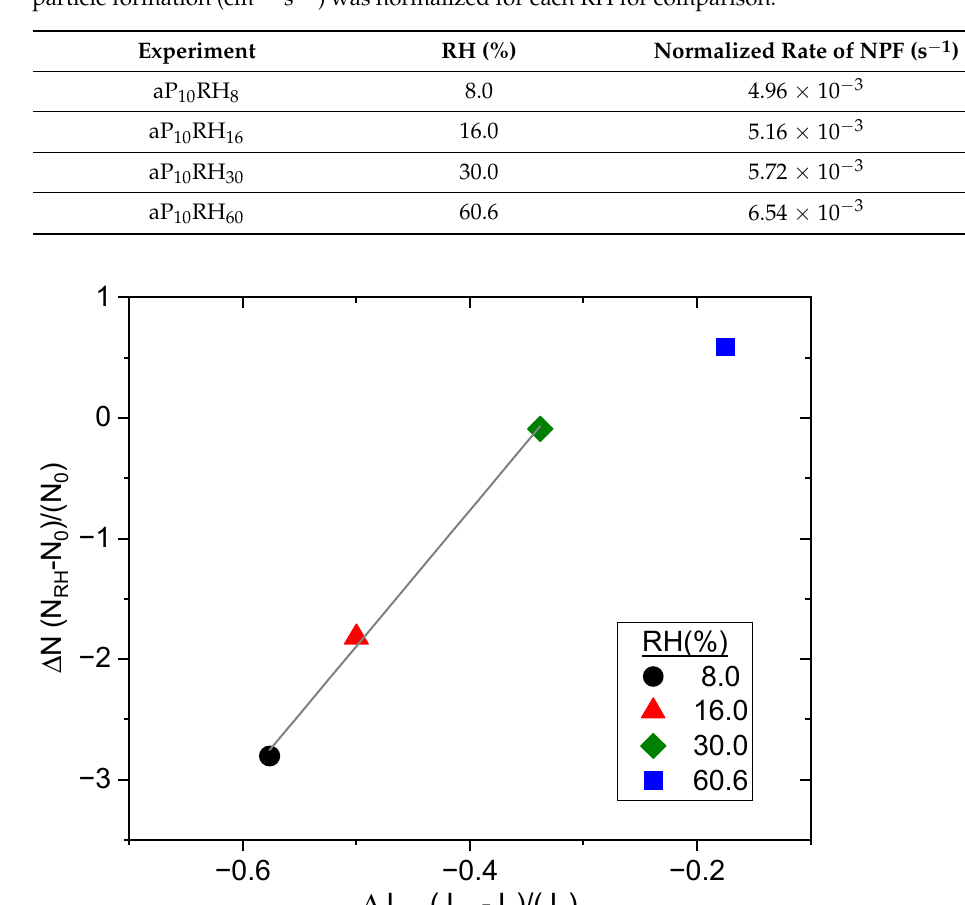
Figure 8. Correlation of ∆ N with ∆ J NR for 10 ppb v α -pinene ozonolysis as a function of RH. ξ O3 = 500 ppb v . Note log scales.